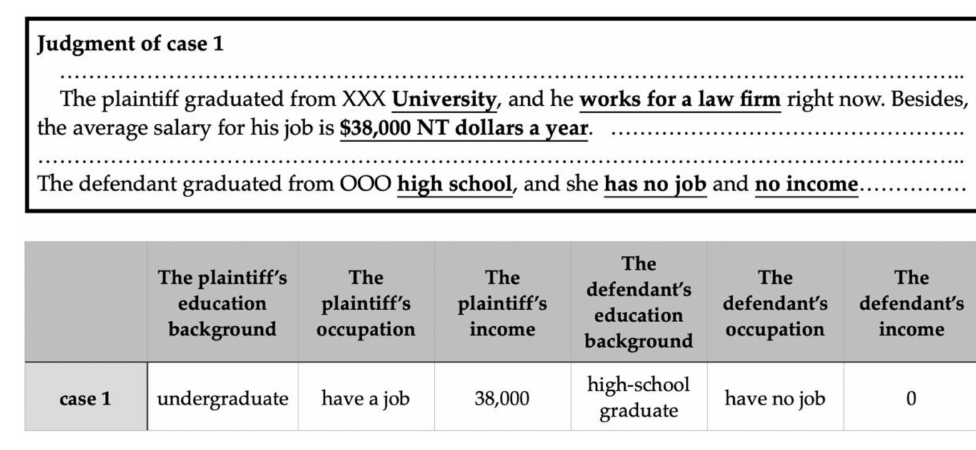
Figure 1. An example of how we extracted legal factors from the judgment